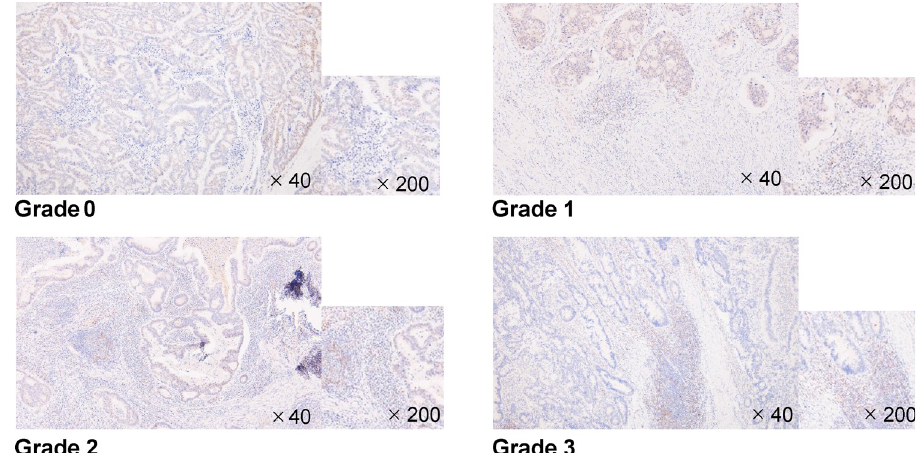
Fig 4. TIGIT immunostaining. TIGIT expression in colorectal cancer (CRC). TIGIT expression in human CRC tissues. Representative case with high (grade 1–3) and low (grade 0) TIGIT expression.